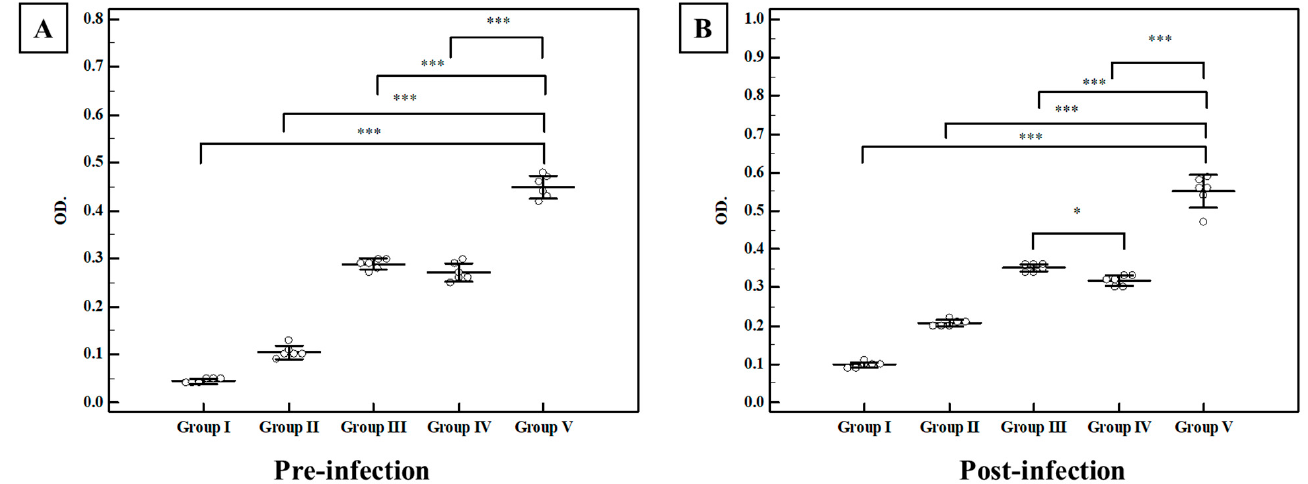
Figure 8. Pre-infection and post-infection serum levels of anti- Toxoplasma IgG (OD) among different studied groups. ( A ) Anti- Toxoplasma IgG antibody levels in sera of mice two weeks following the last booster dose of immunization (pre-infection). ( B ) Anti- Toxoplasma IgG antibody level in sera of mice four weeks after challenging the infection (post-infection). Data were expressed by using Mean ± SD. ***: Statistically significant at p ≤ 0.001. *: Statistically significant at p ≤ 0.05. Group I: Control